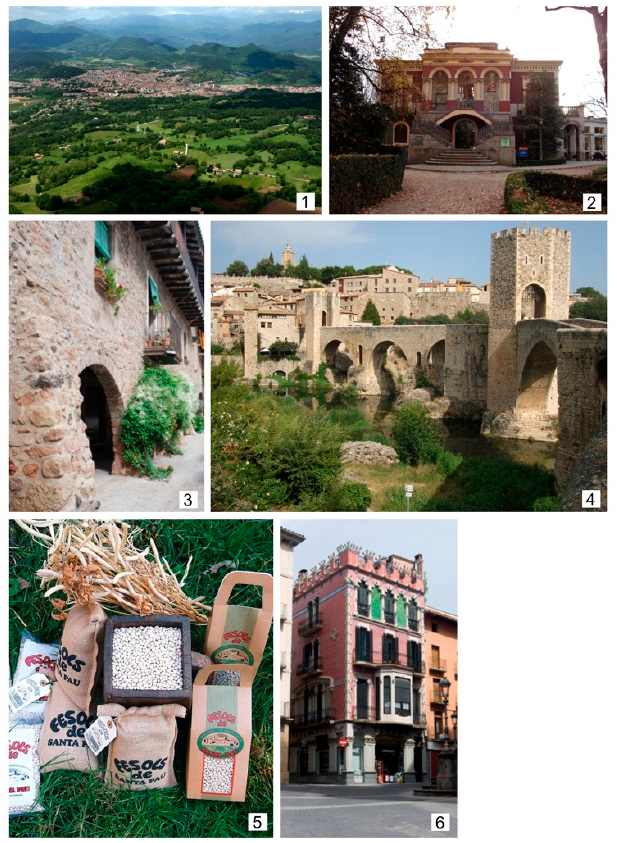
Figure 5. Photographs of the main natural and cultural sites. ( 1 ) Olot city; ( 2 ) Volcano Museum (Casal dels Volcans); ( 3 ) The medieval centre of Santa Pau; ( 4 ) Besalú medieval town; ( 5 ) Santa Pau haricot beans; ( 6 ) The Gaietà Vila Art Nouveau house in Olot. Source: Documentation Centre, Garrotxa Volcanic Zone Natural Park.